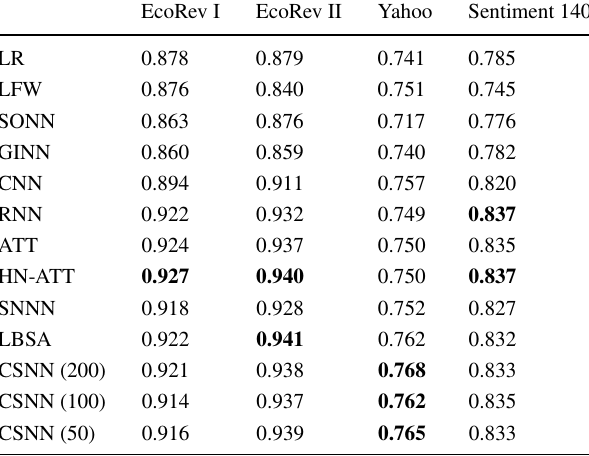
Table 7 F 1 score results for the predictability evaluation